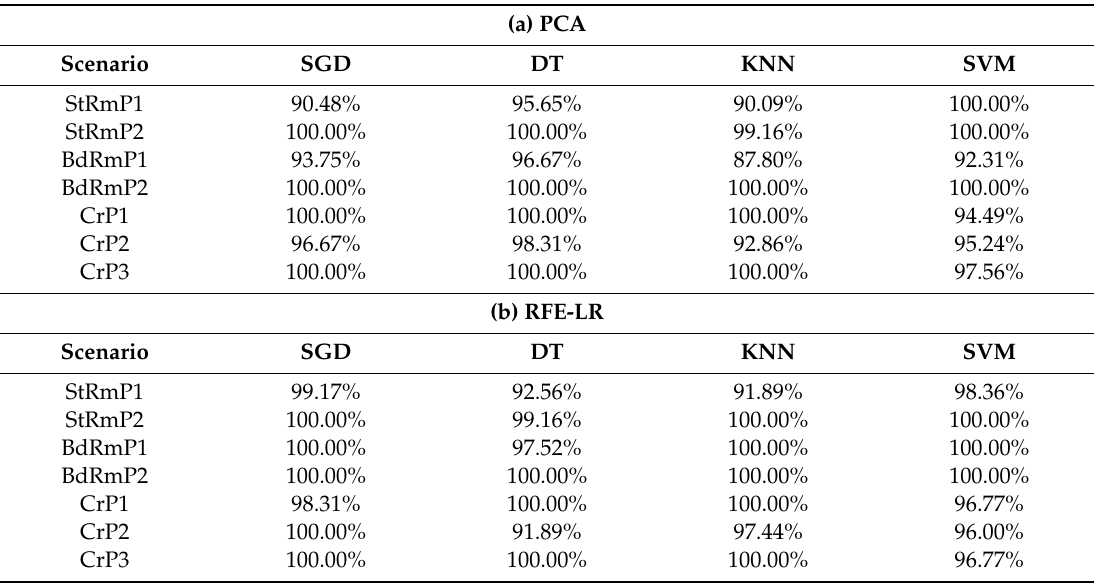
Table 5. The classifiers’ performance at di ff erent